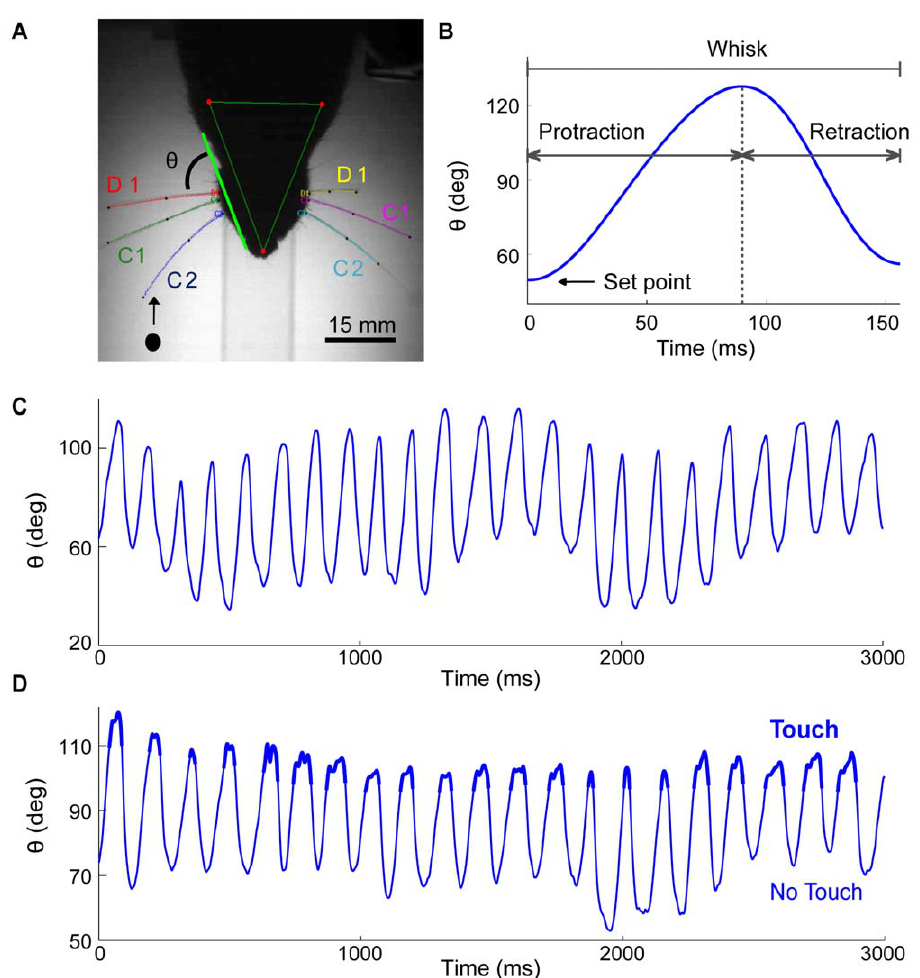
Figure 1. Acquisition and pre-processing of whisker trajectories in rats. A. Overhead view of a head-fixed rat with whiskers C2, C1, and D1. The instantaneous whisker angle, h , was defined as the angle between the whisker base and the nose-eye line. The pole is marked schematically in its typical initial location, with an arrow indicating the direction of its motion into the whisking field of the rat. B. The protraction and retraction phases of a single whisk are depicted in relation to whisker angle and protraction onset time. The angle of the whisker on the whisk’s onset (set point) is indicated by an arrow. C. Example of a free-air whisking trajectory (filtered at 80 Hz). D. Example of a whisking trajectory against an object (filtered at 80 Hz). Whisker-pole contact is indicated by bold. In this example, the rat made 21 successive whisks with